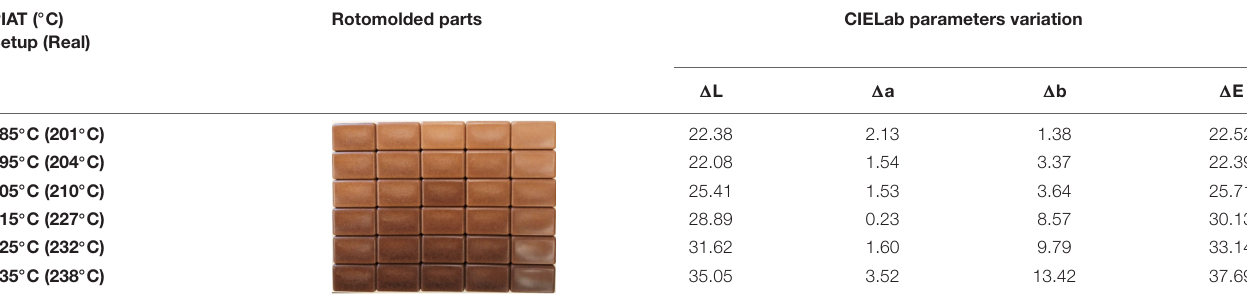
FIGURE 4 | Mold internal air temperature profiles during the rotational molding process of (A) MDPE and MDPE/10% cork parts and (B) MDPE/10% cork parts processed at different IAT. The arrow indicates the direction of increase in the IAT setup used for processing the parts. TABLE 3 | Repeatability studies of MDPE/10% MF8 cork parts at different processing temperatures and CIELab color parameter variations in relation to the neat cork